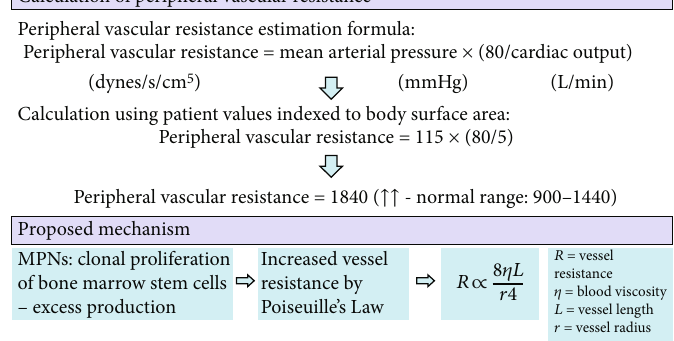
Figure 4: Case 2 — Vessel resistance calculation and suggested mechanism for increase. Elevated peripheral vascular resistance with nonhealing ulcers could indicate vasoconstriction and microvascular